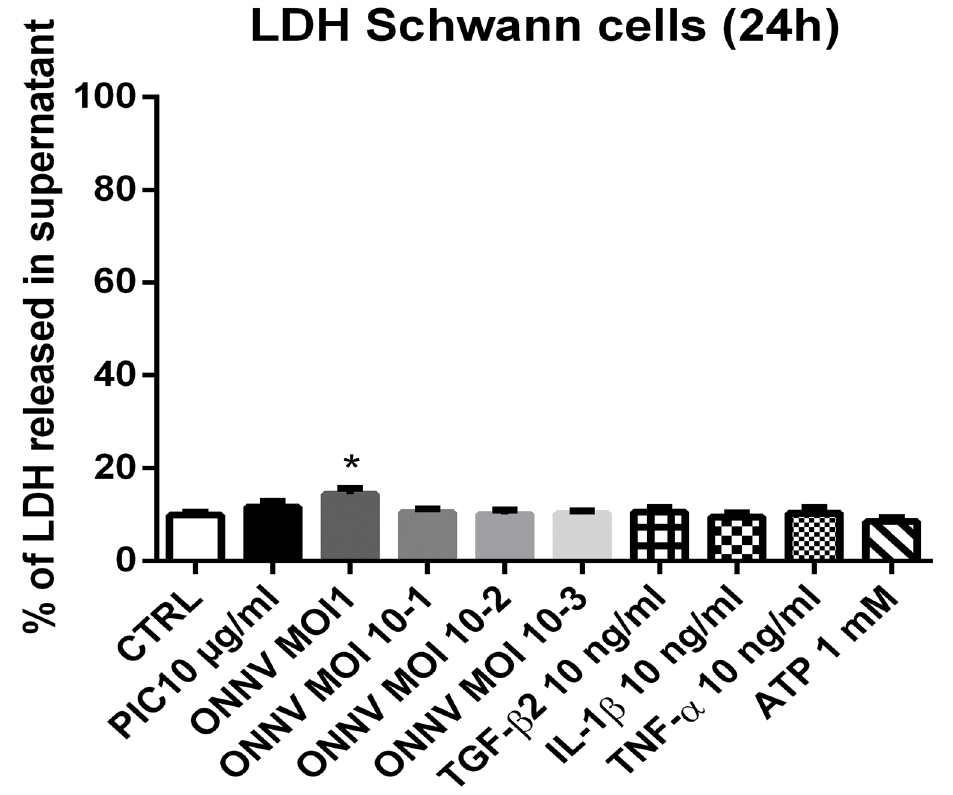
Figure 3. ONNV does not cause SC cytotoxicity at 24 h. SC were infected with ONNV (from MOI 10 − 3 to 1) or exposed to stimulatory treatments (PIC 10 μ g/mL, IL ‐ 1 β 10 ng/mL, TNF ‐α 10 ng/mL, TGF ‐β 2 10 ng/mL, and ATP 1 mM) for 24 h. The percentage of LDH released in the culture super ‐ natant was measured using the CytoTox 96 Non ‐ Radioactive Cytotoxicity Assay. Results are from 4 independent experiments. * p ‐ values ≤ 0.05 represent significant differences from controls (CT) by one ‐ way ANOVA followed by the Bonferroni’s test analysis.